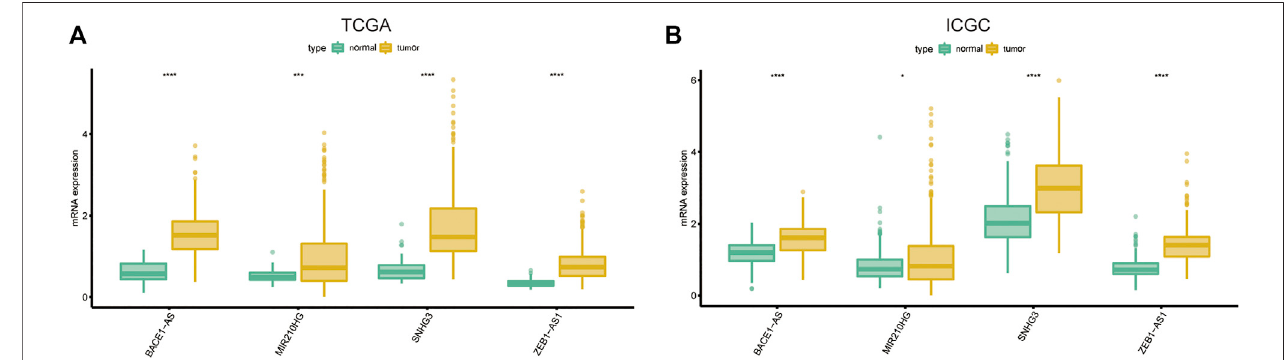
FIGURE 4 | The expression of the four screened lncRNAs in HCC tissues and normal tissues in the TCGA (A) and ICGC (B) dataset. HCC, Hepatocellular carcinoma; TCGA, The Cancer Genome Atlas; ICGC, International Cancer Genome Consortium.